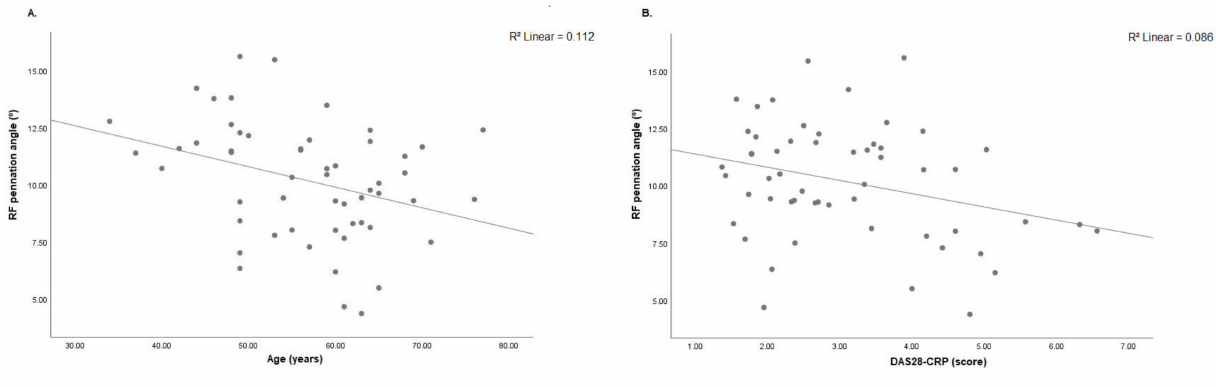
Figure 7. ( A ) Correlation analysis was significant between RF pennation angle and age ( n = 55, r = − 0.334; p = 0.013) and ( B ) DAS28-CRP ( n = 55, r = − 0.293; p = 0.030). RF: rectus femoris; ◦ : degrees; DAS28-CRP: 28-joint disease activity score, C-reactive